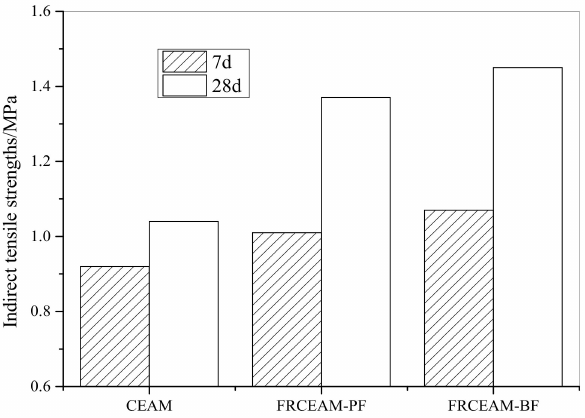
Figure 2. ITS of CEAM and